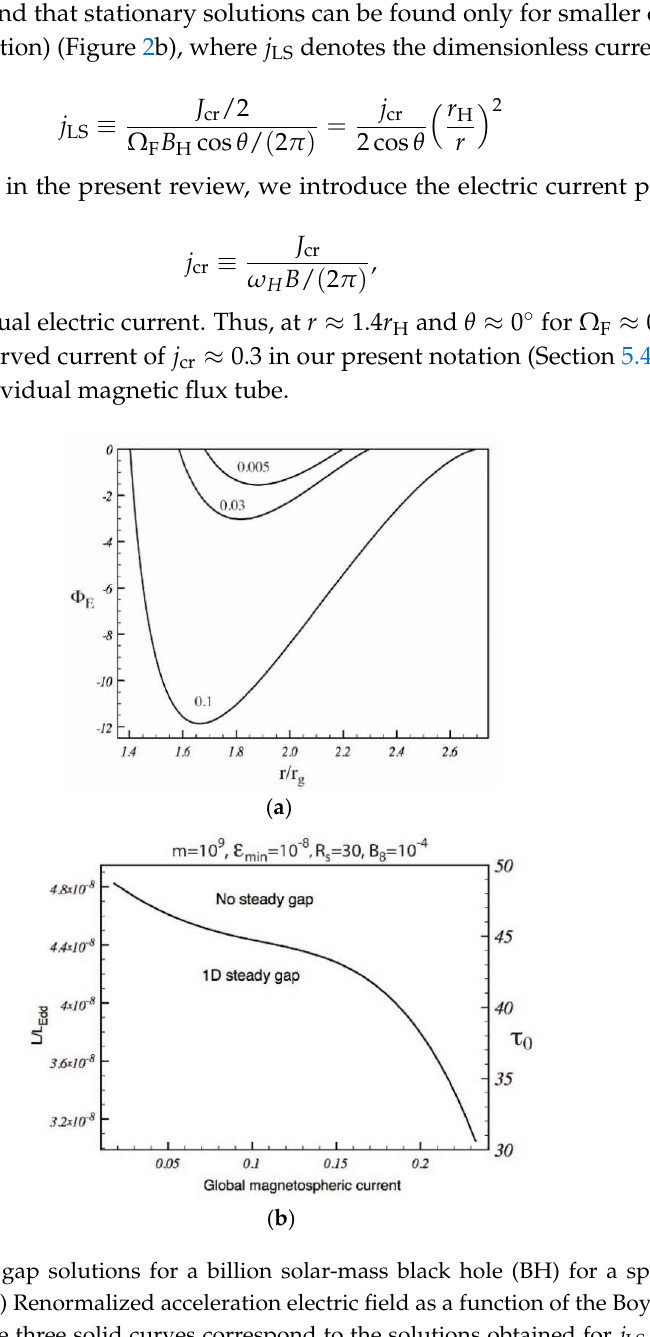
0.01 j  (dashed curve), 0.03 (solid = 3 × 10 8 cm, E is substantially  